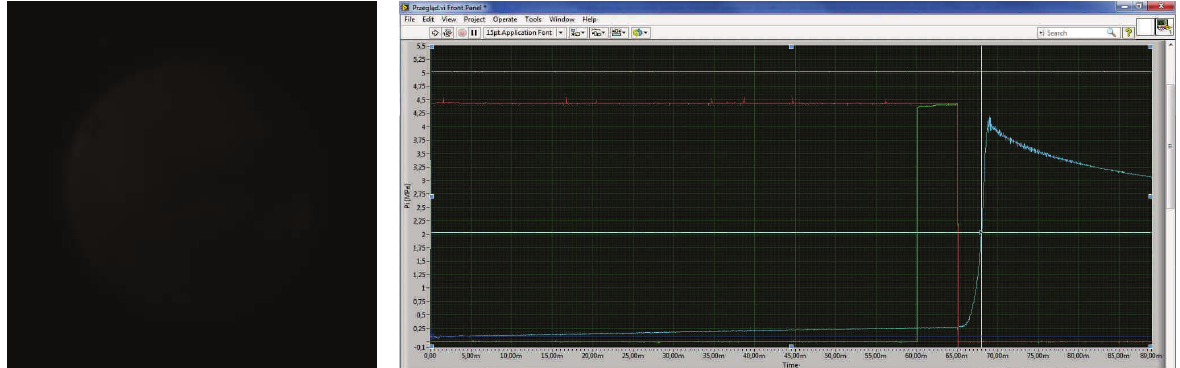
Fig. 3a. Photo of the combustion process and the pressure course with the marked pressure value. 3 ms after the combustion initiation